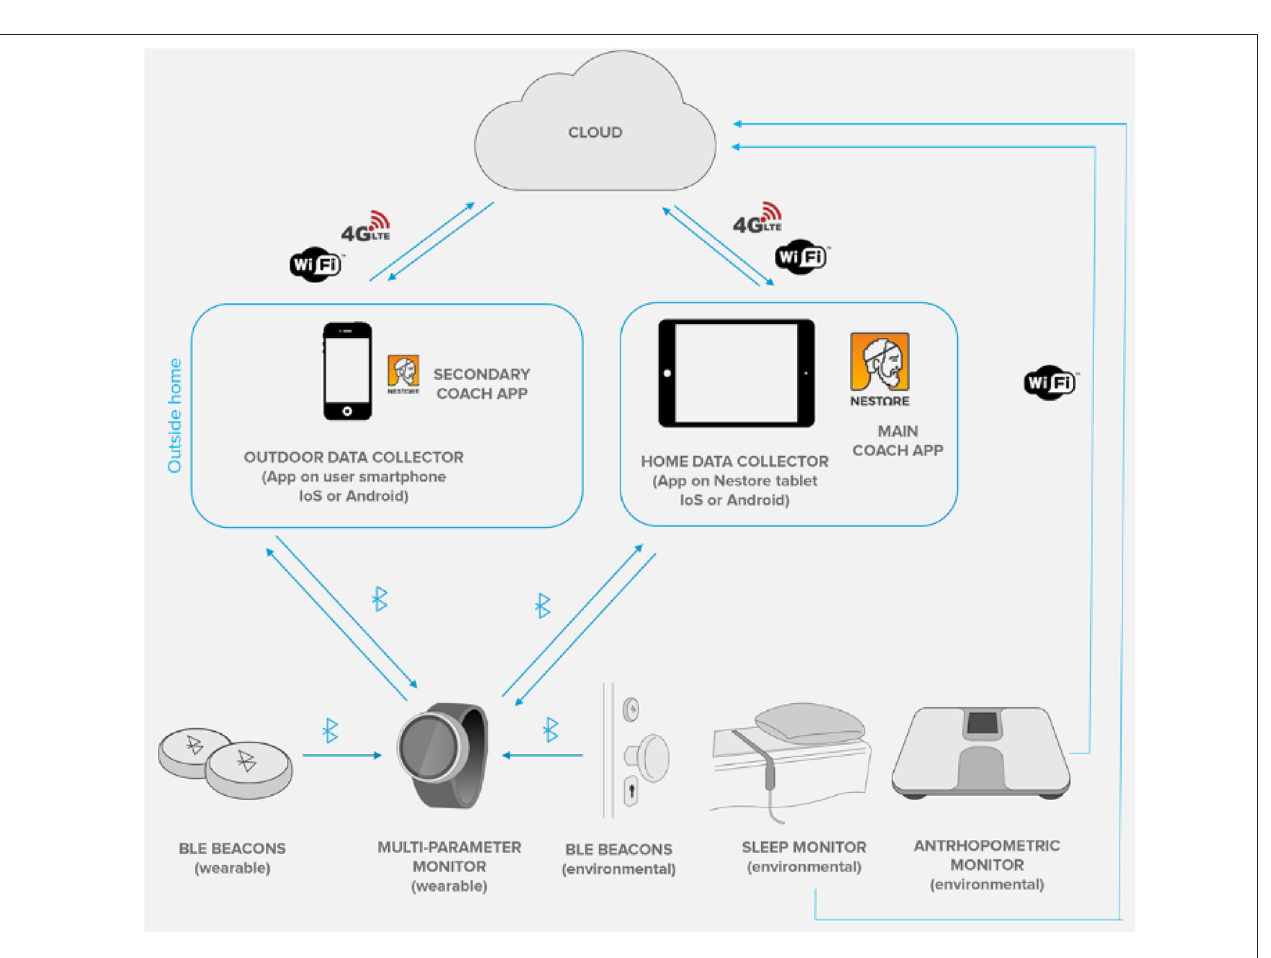
FIGURE 7 | Overview of the monitoring system